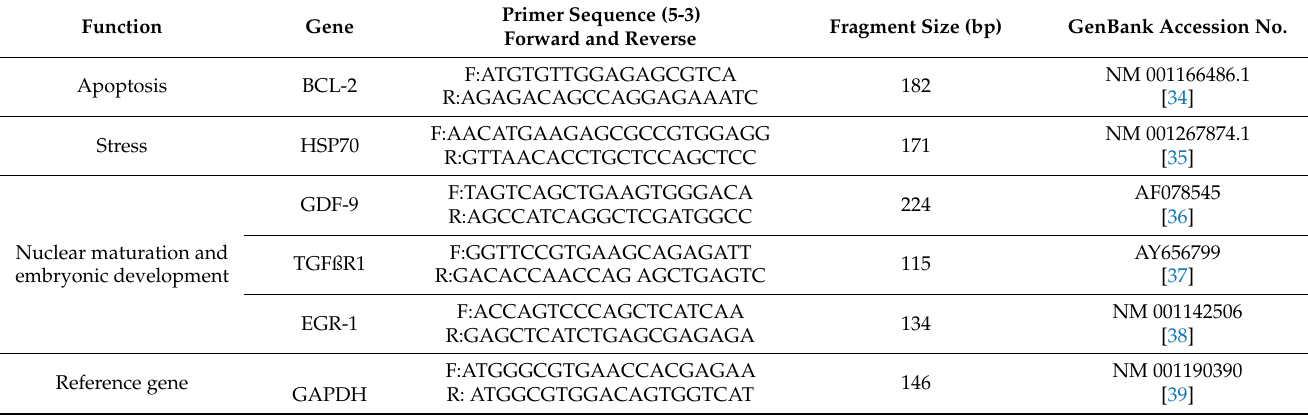
Table 1. The serial composition of the primers used to measure gene expression in sheep oocytes and